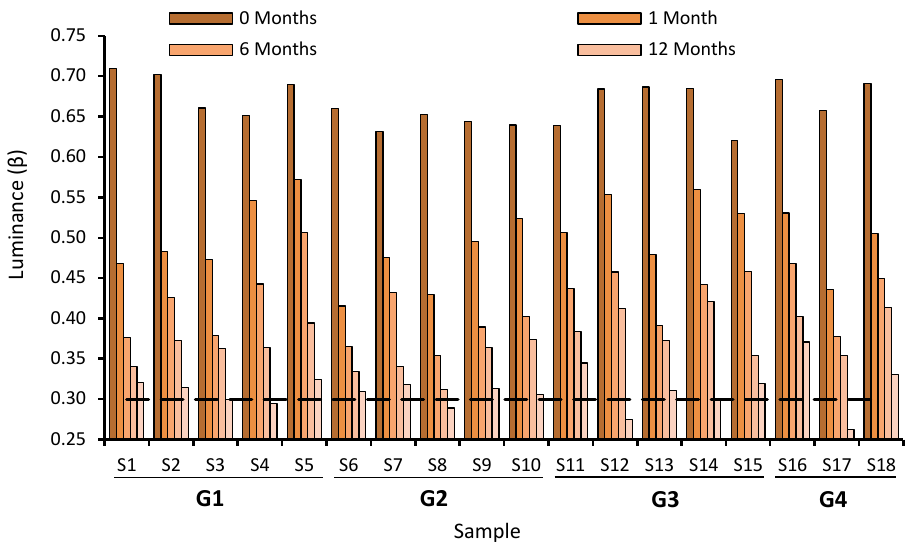
Figure 7. Evolution of the average luminance factor β in the 18 testing samples.